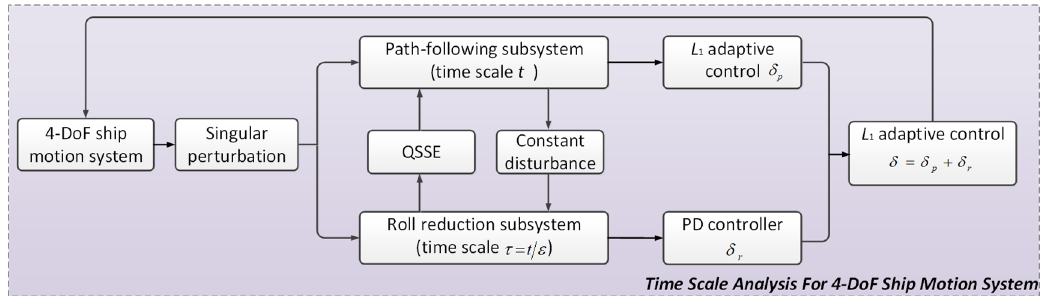
Figure 1. Overall scheme of the time-scale analysis for the control system of 4-DoF ship motion.